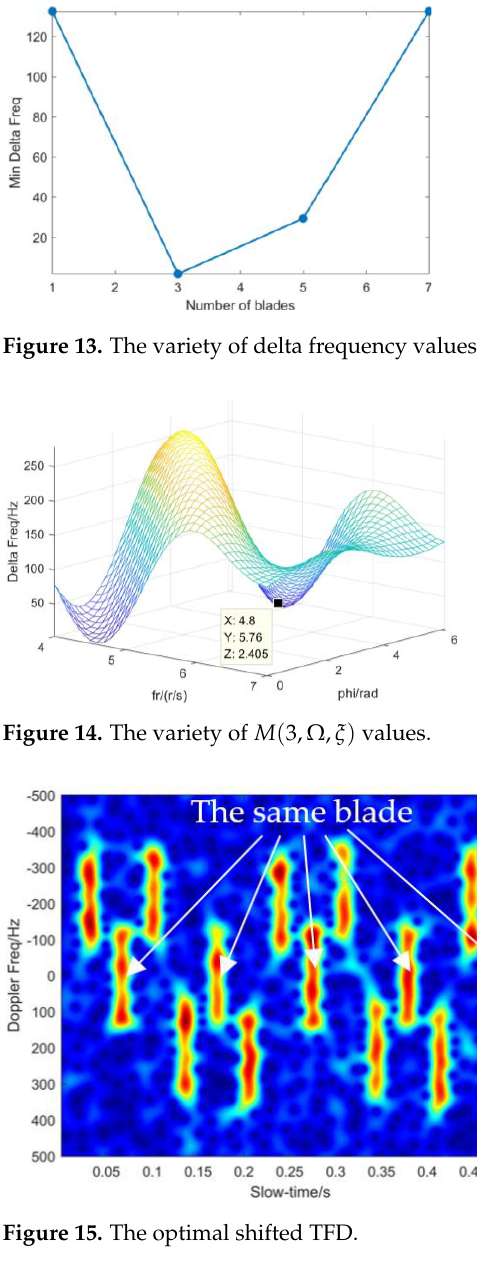
( c ) Figure 16. The parameters estimation RMSEs: ( a ) estimation RMSE of K ; ( b ) estimation RMSE of fr ; ( c ) estimation RMSE of L. Firstly, it can be seen from Figure 16a that these four methods can all obtain accurate the blade number for the rotors when the SNR is greater than − 40 dB. Even the TFFS, HT, and GLRT methods can obtain the correct blade number when the SNR is as low as − 47 dB. However, Figure 16a illustrates that the OMP algorithm cannot obtain the true blade number when the SNR is smaller than − 40 dB. Accordingly, the proposed TFFS algorithm is more robust than the OMP algorithm at low SNRs. Figure 16b,c show the RMSEs of the